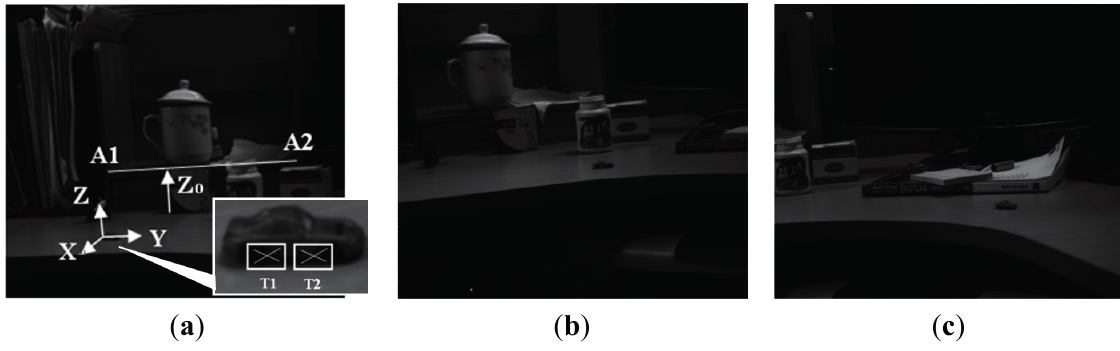
Figure 11. The image sequence of the moving car. ( a ) The 1st image and the coordinate determination; ( b ) The 5 th image; ( c ) The 11th